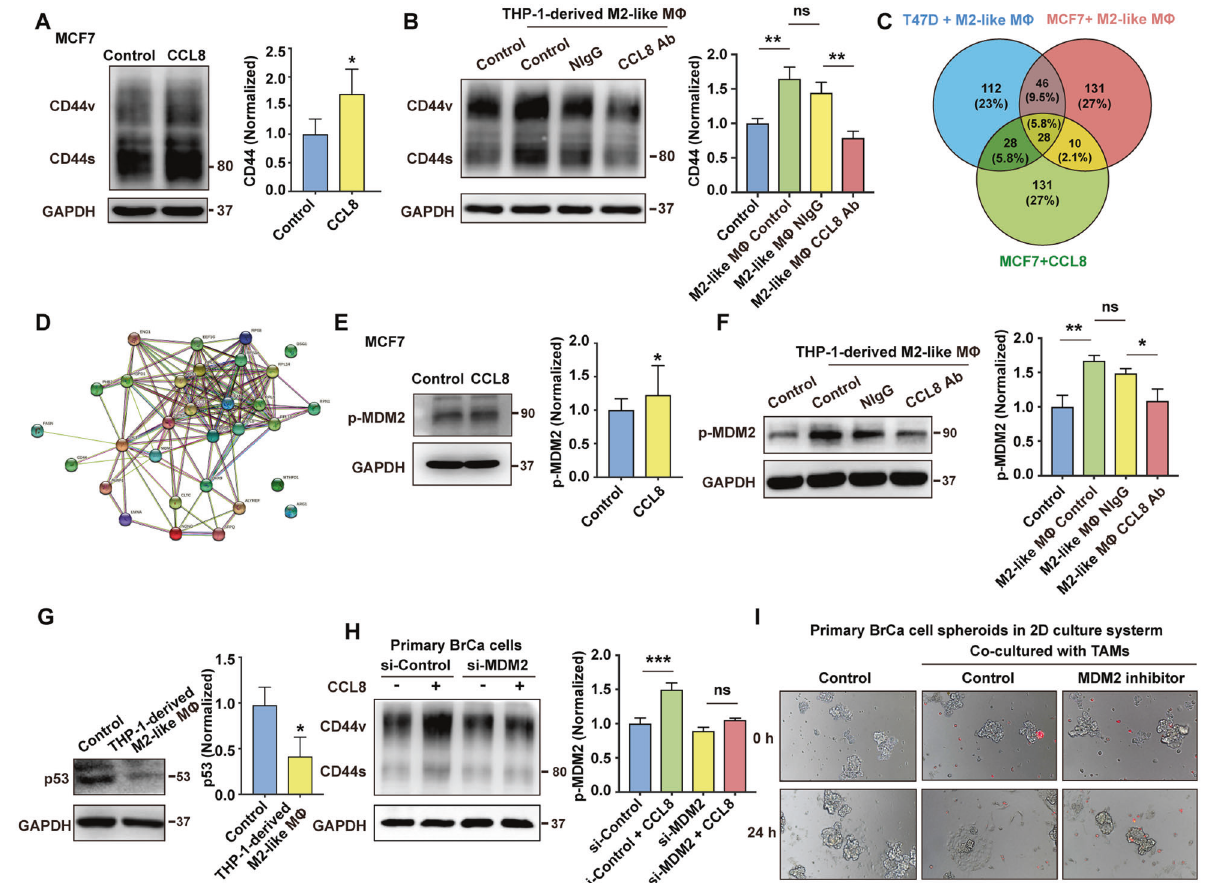
Fig. 5 The activation of MDM2-p53 signaling pathway in CD44 high state induced by CCL8. A The in fl uence of CCL8 on the expression of CD44 in MCF7 cells was evaluated by western blot. The band intensities were analyzed by densitometry analysis. * p < 0.05. B Blocking of CCL8 inhibited the acquisition of CD44 high state in MCF7 cells induced by M2-like macrophages, which was obtained from human monocytic cell line THP-1 stimulated by PMA/m-CSF/IL-4/IL-10/IL-13. The band intensities were analyzed by densitometry analysis. ** p < 0.01, ns: no signi fi cance. C Scheme of identifying differential CD44-interacting peptides upon THP-1-derived M2-like macrophages/CCL8 stimulation. The intersection showed the CD44-interacting proteins, which were analyzed by co-immunoprecipitation-based mass spectrometry assay. MCF7 and T47D cells were stimulated by THP-1-derived M2-like macrophages or CCL8 for 3 days, respectively. The proteins recruited to CD44 were precipitated by CD44 antibody, and then subject to mass spectrometry assay. D Functional associations of the regulatory networks of MDM2/ p53-correlated genes from analysis of STRING data are presented. E The effects of CCL8 on the activation of MDM2 in MCF7 cells were evaluated by immunoblotting assay. The band intensities were analyzed by densitometry analysis. * p < 0.05. F Blocking of CCL8 inhibited the activation of MDM2 in MCF7 cells induced by THP1-derived M2-like macrophages. The band intensities were analyzed by densitometry analysis. * p < 0.05, ** p < 0.01, ns: no signi fi cance. G Repression of p53 expression by M2-like macrophages in human BrCa cells was detected by immunoblotting assay. The band intensities were analyzed by densitometry analysis. * p < 0.05. H Knocking down of MDM2 in primary BrCa cells inhibited the up-regulation of CD44 induced by TAMs. The band intensities were analyzed by densitometry analysis. *** p < 0.001, ns: no signi fi cance. I The in fl uence of MDM2 inhibitor on collective dissemination of cell clusters induced by TAMs in 2D culture system. Before co- cultured with TAMs on 2D culture system, primary BrCa cell clusters were obtained from an ultra-low attachment culture system. TAMs were pre-stained with Vybrant CM-DiI